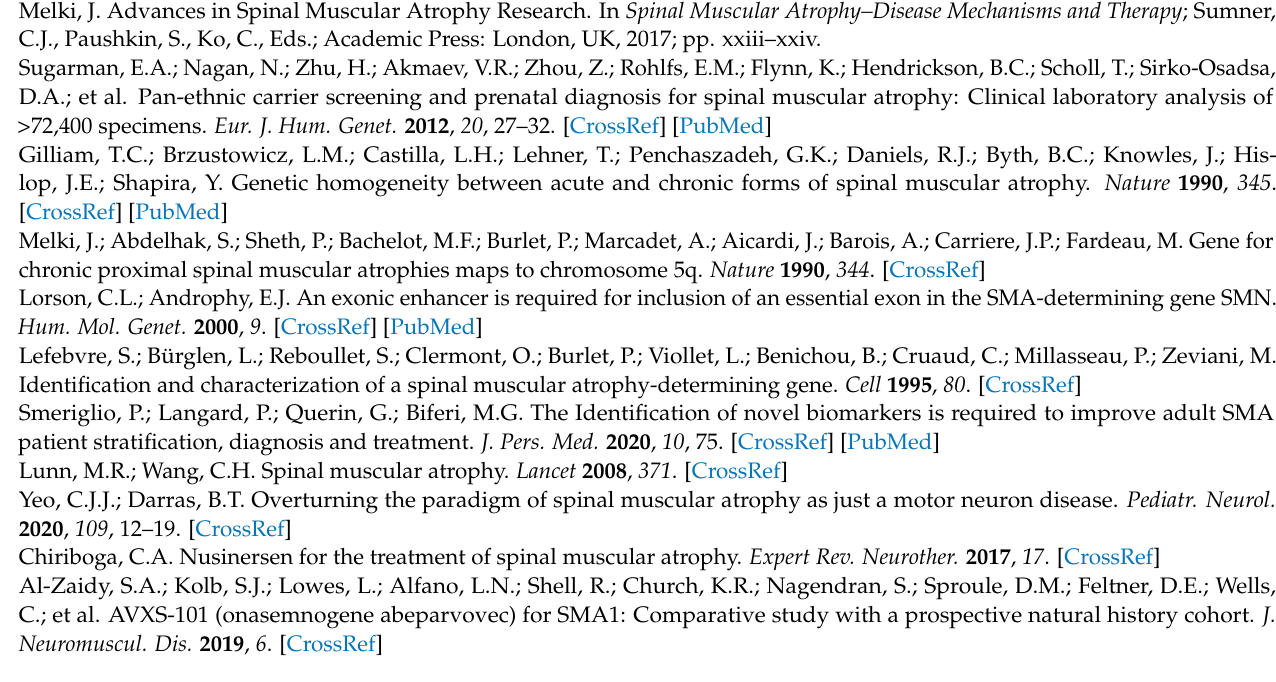
Table S3: Performance metrics, Instructions for running a model on a local machine, model.zip (model, java executor and test data